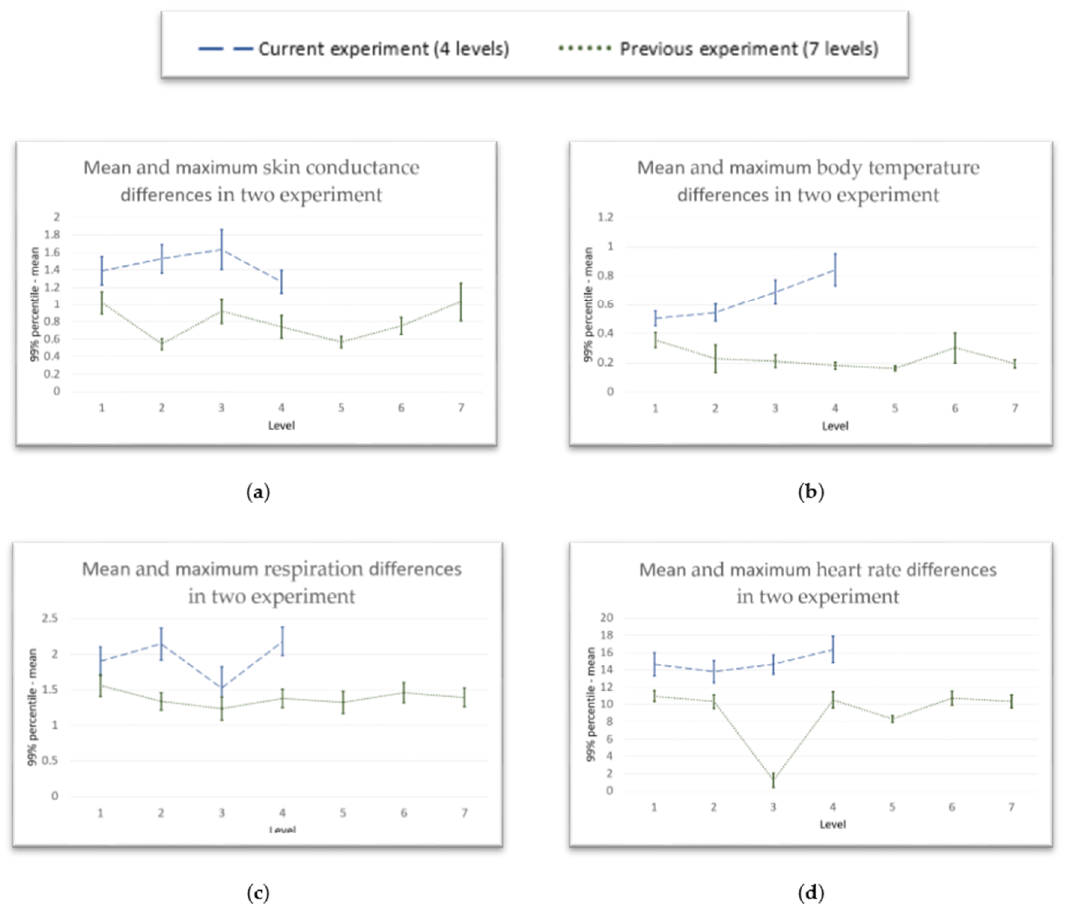
Figure 10. ( a ) Mean and maximum skin conductance differences in two experiments; ( b ) mean and maximum body temperature differences in two experiments; ( c ) mean and maximum respiration differences in two experiments; and ( d ) mean and maximum heart rate differences in two